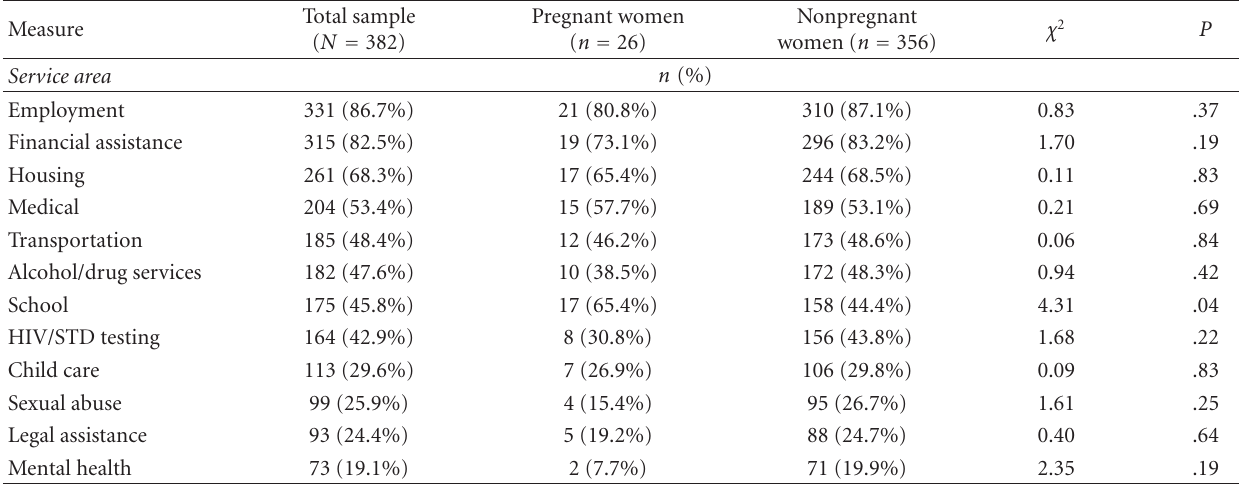
Table 3: Areas in which participants expressed a need for a social service ( N =